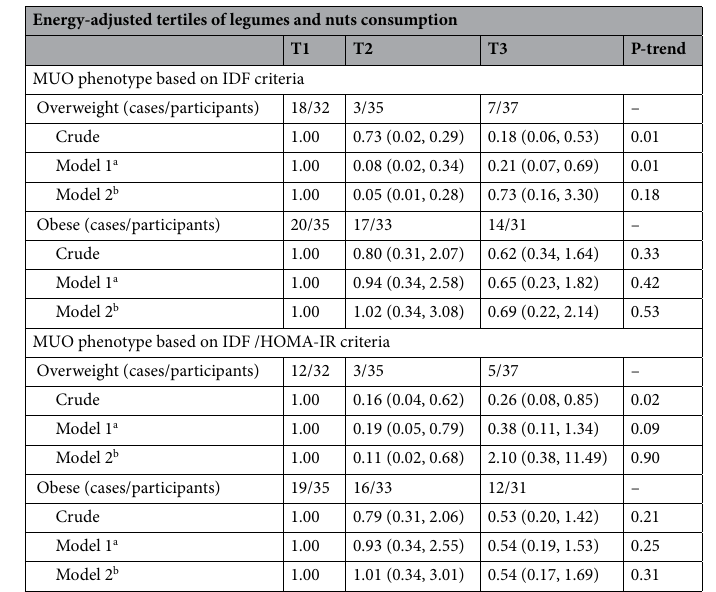
Table 5. Multivariate adjusted odds ratio (OR) and 95% confidence interval (CI) for MUO across energy- adjusted tertiles of legumes and nuts consumption stratified by BMI categories. All values are odds ratios and 95% confidence intervals. a Model 1: adjusted for age, sex and energy intake. b Model 2: additionally adjustments for physical activity and socioeconomic status (parental education, parental job, number of family members, having car in the family, having computer/laptop, having personal room and having